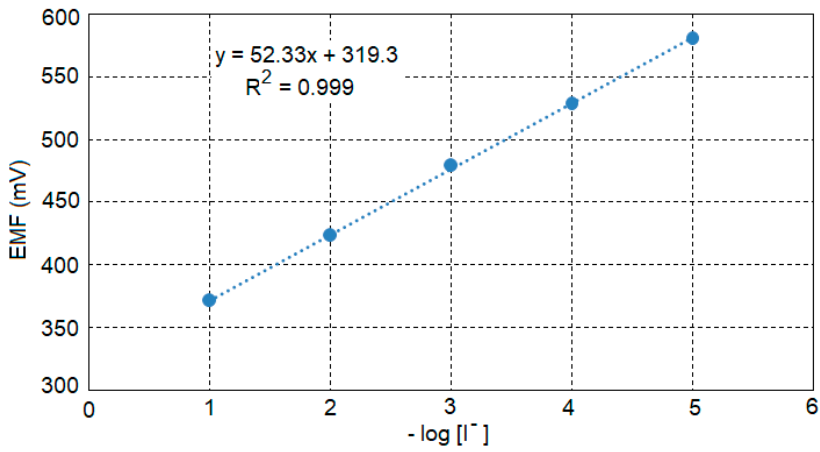
Figure 7. The potentiometric response of sensor C toward iodide.